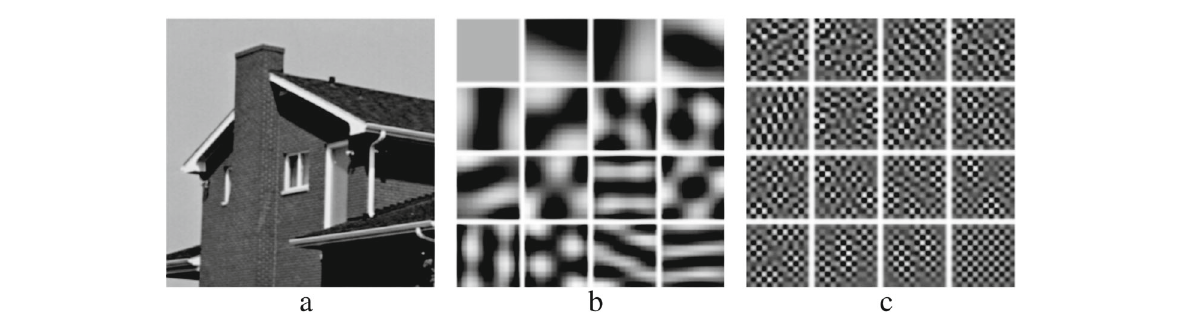
Fig. 6 The principal components “axis” of the house image: a is the input image, b is the first 16 principal axes of the all patches obtained from the house image, and c is the last 16 principal axes of the all patches obtained from the house image [13]